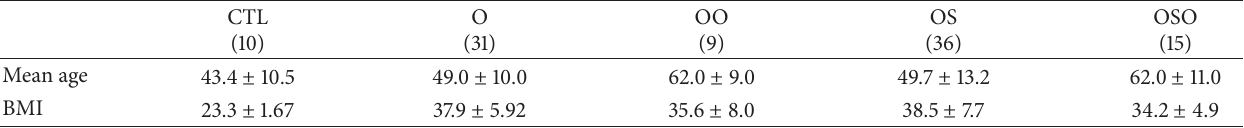
Table 1: Anthropometric data of the subjects involved in the study.